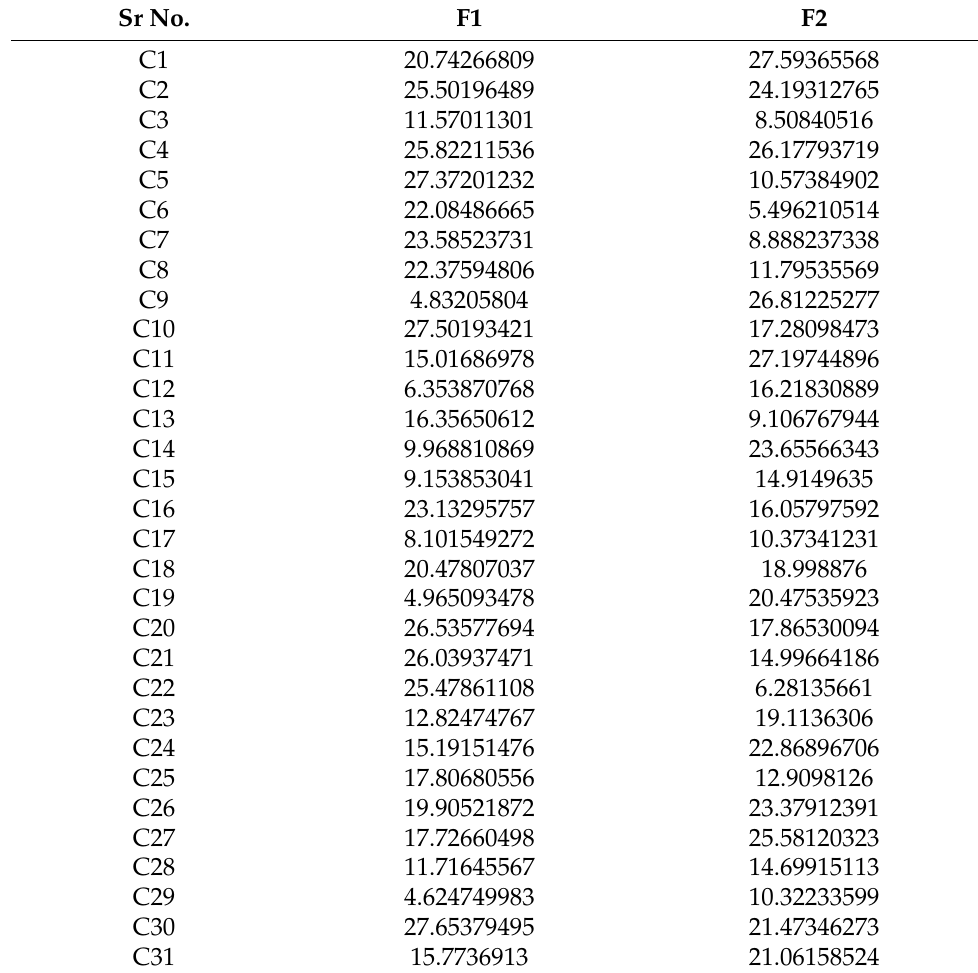
Table 10. The best centroids for D31 obtained by proposed approach.